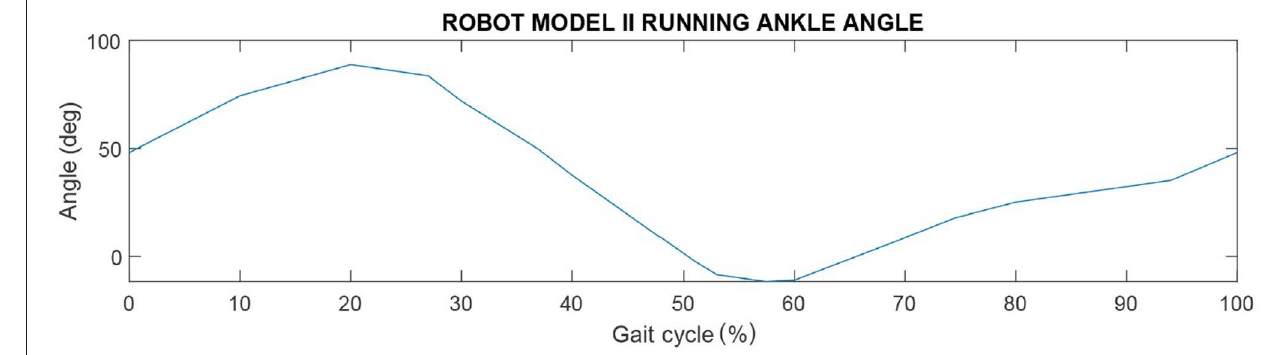
FIGURE 6 | Ankle angle input for Robot model II running gait.